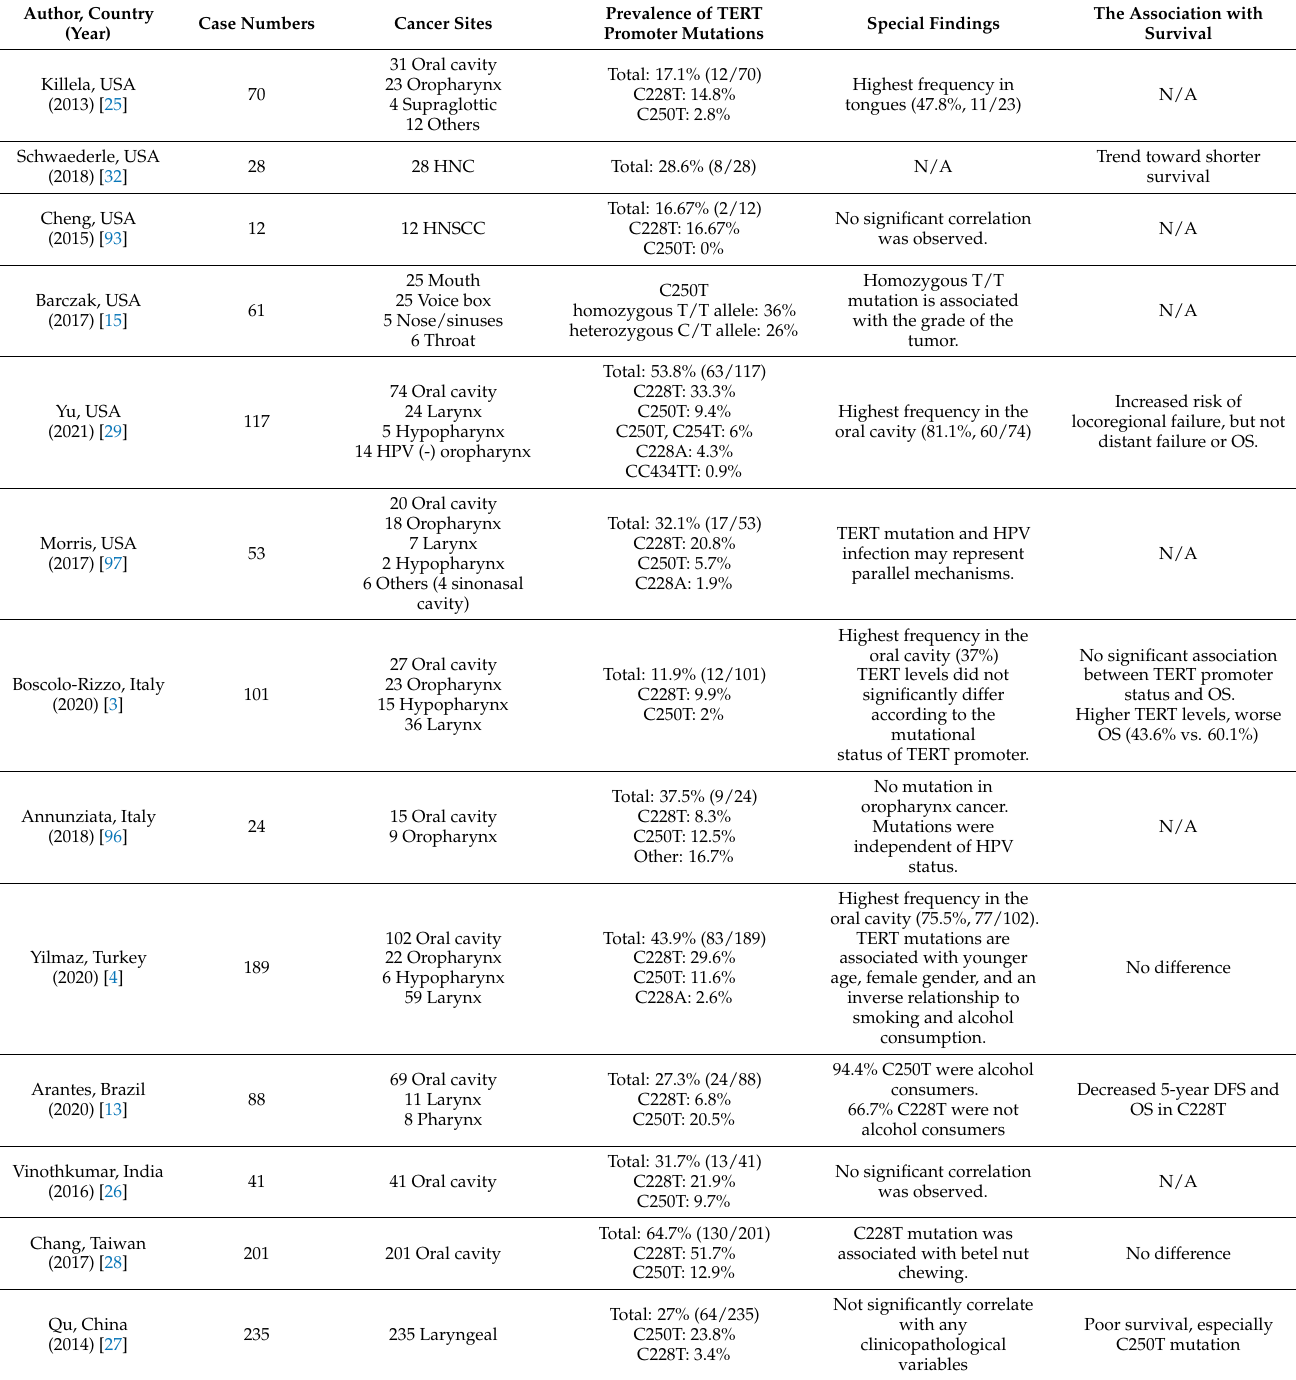
Table 2. Summary of studies evaluating the association between head and neck cancers with TERT promoter